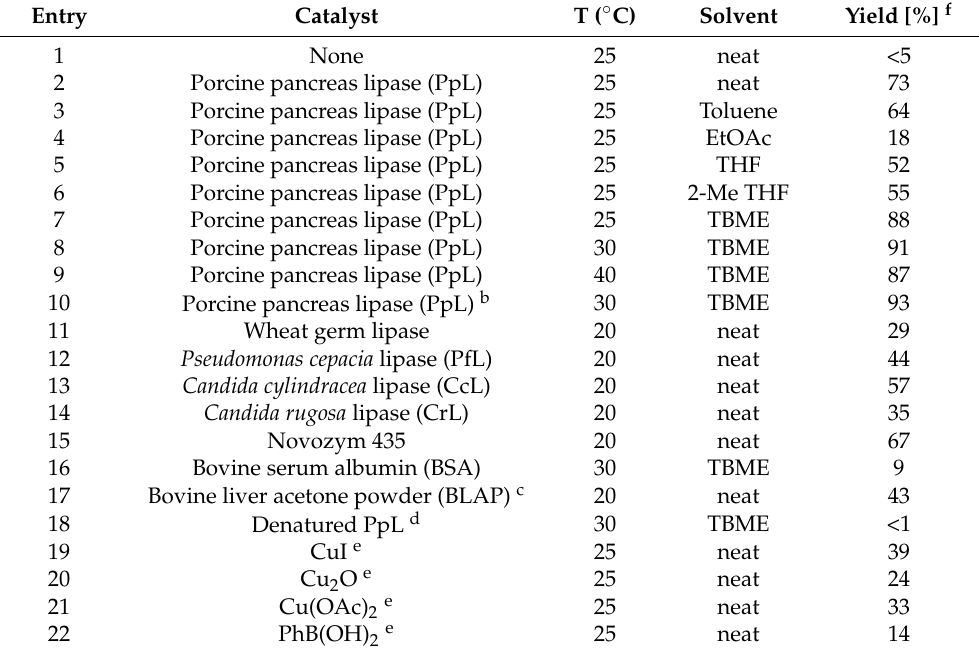
Table 1. Model Kabachnik–Fields reaction catalyzed by enzymes. [a] Optimization studies. Entry Catalyst T ( ◦ C) Solvent Yield [%] f 1 None 25 neat <5 2 Porcine pancreas lipase (PpL) neat Porcine pancreas lipase